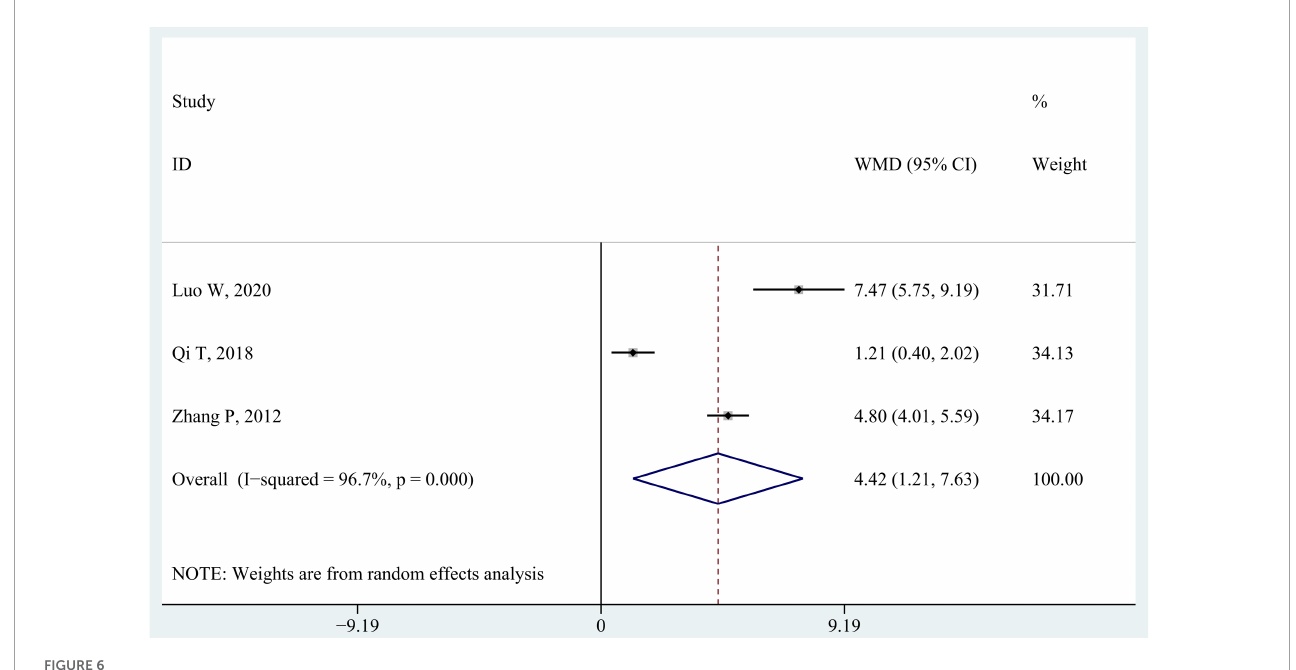
FIGURE6 Forest plot of pooled results for Berg balance